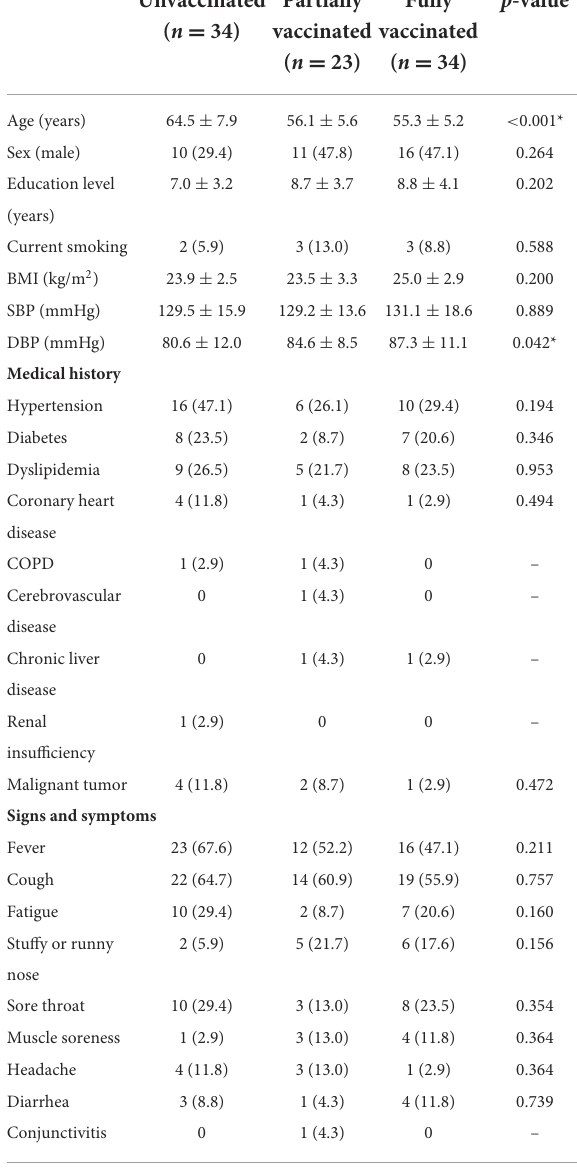
TABLE 1 Characteristics and clinical features of COVID-19 patients with different vaccination